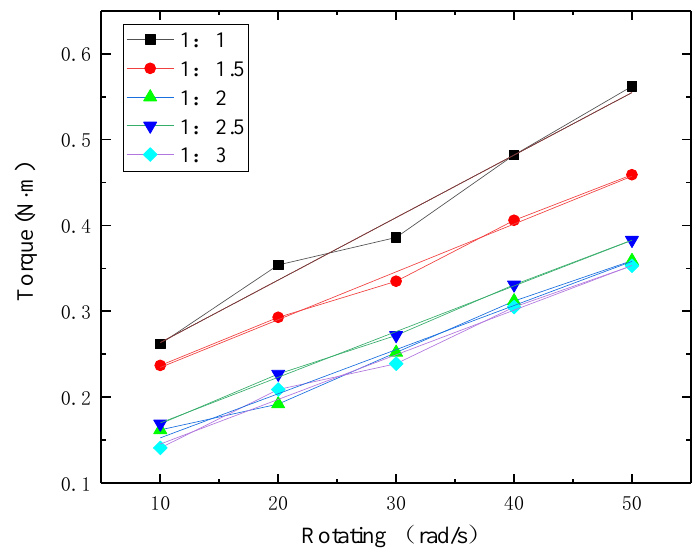
Figure 10. Relation between rotating speed and torque at different ratios of fine particles to coarse particles. Table 10. Relation between rotating speed and torque at different ratios of fine particles to coarse particles of the slurry and the resulting rheological parameters. Ratio of Fine